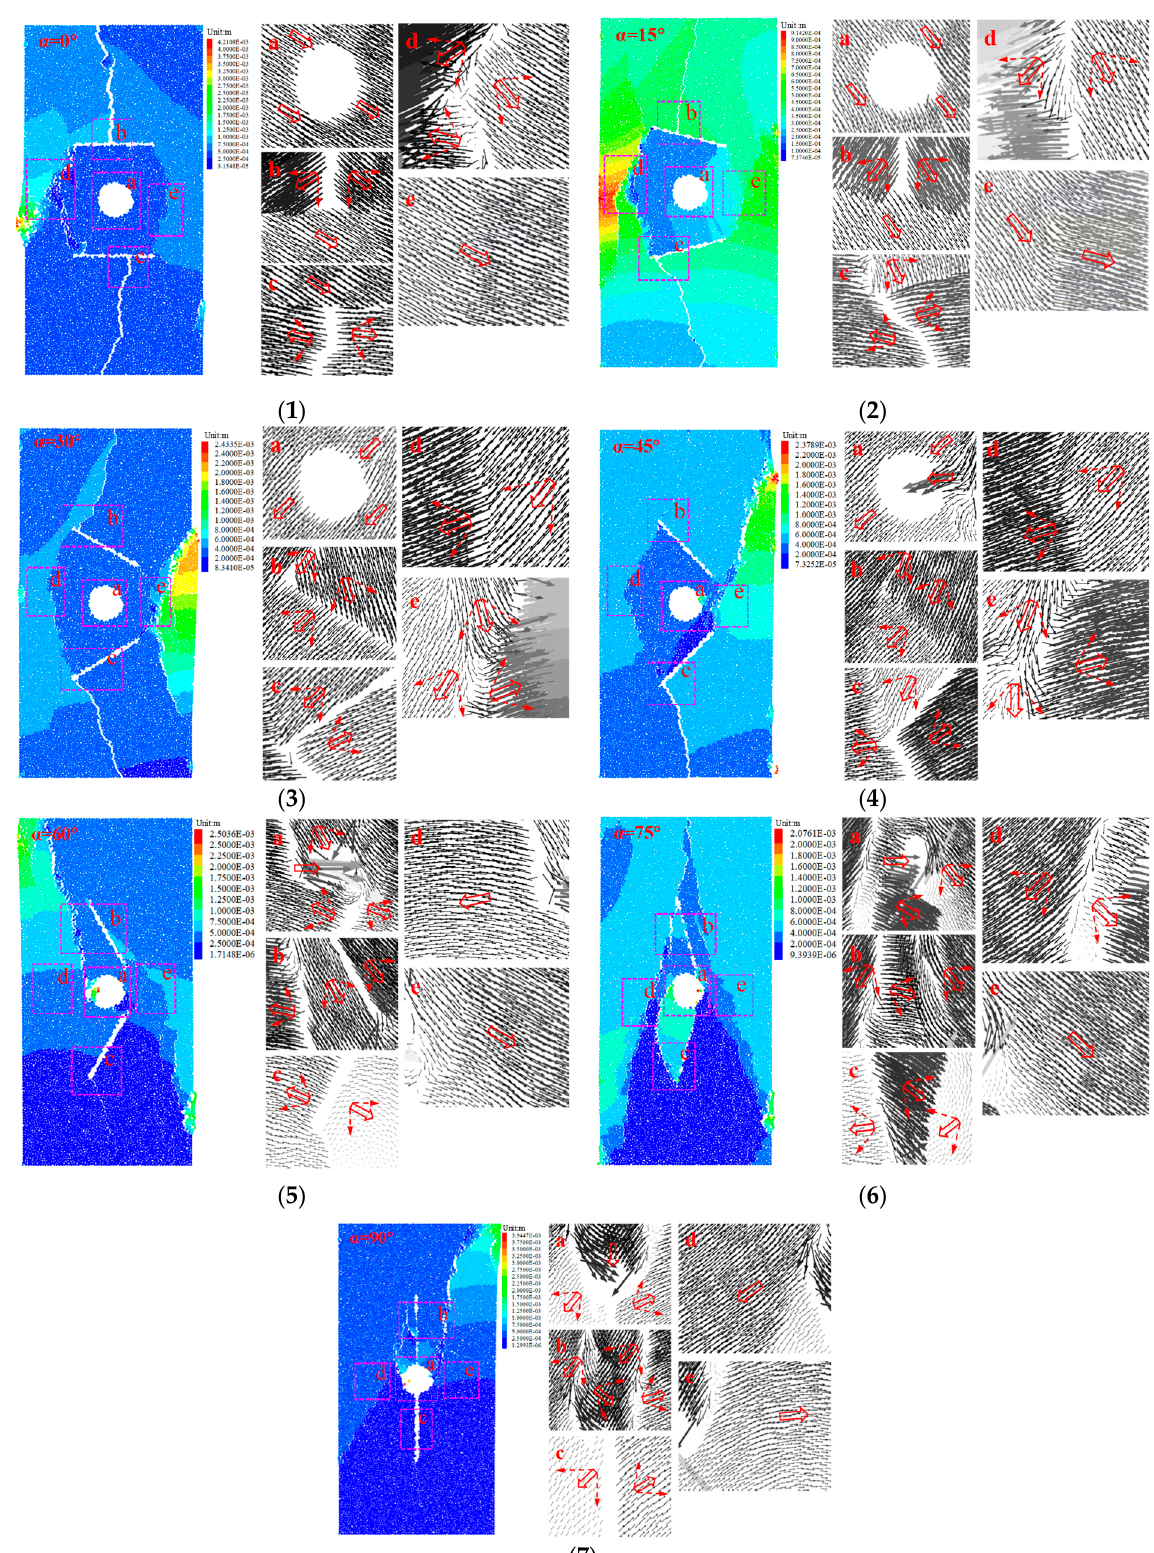
Figure 11. Displacement vector distribution of composite sample with defects after failure under uniaxial compression. The cracks through the hole occurred from the upper left side of the specimen with α = 60°, and the cracks from the top to the middle of the sample with α = 75° penetrate